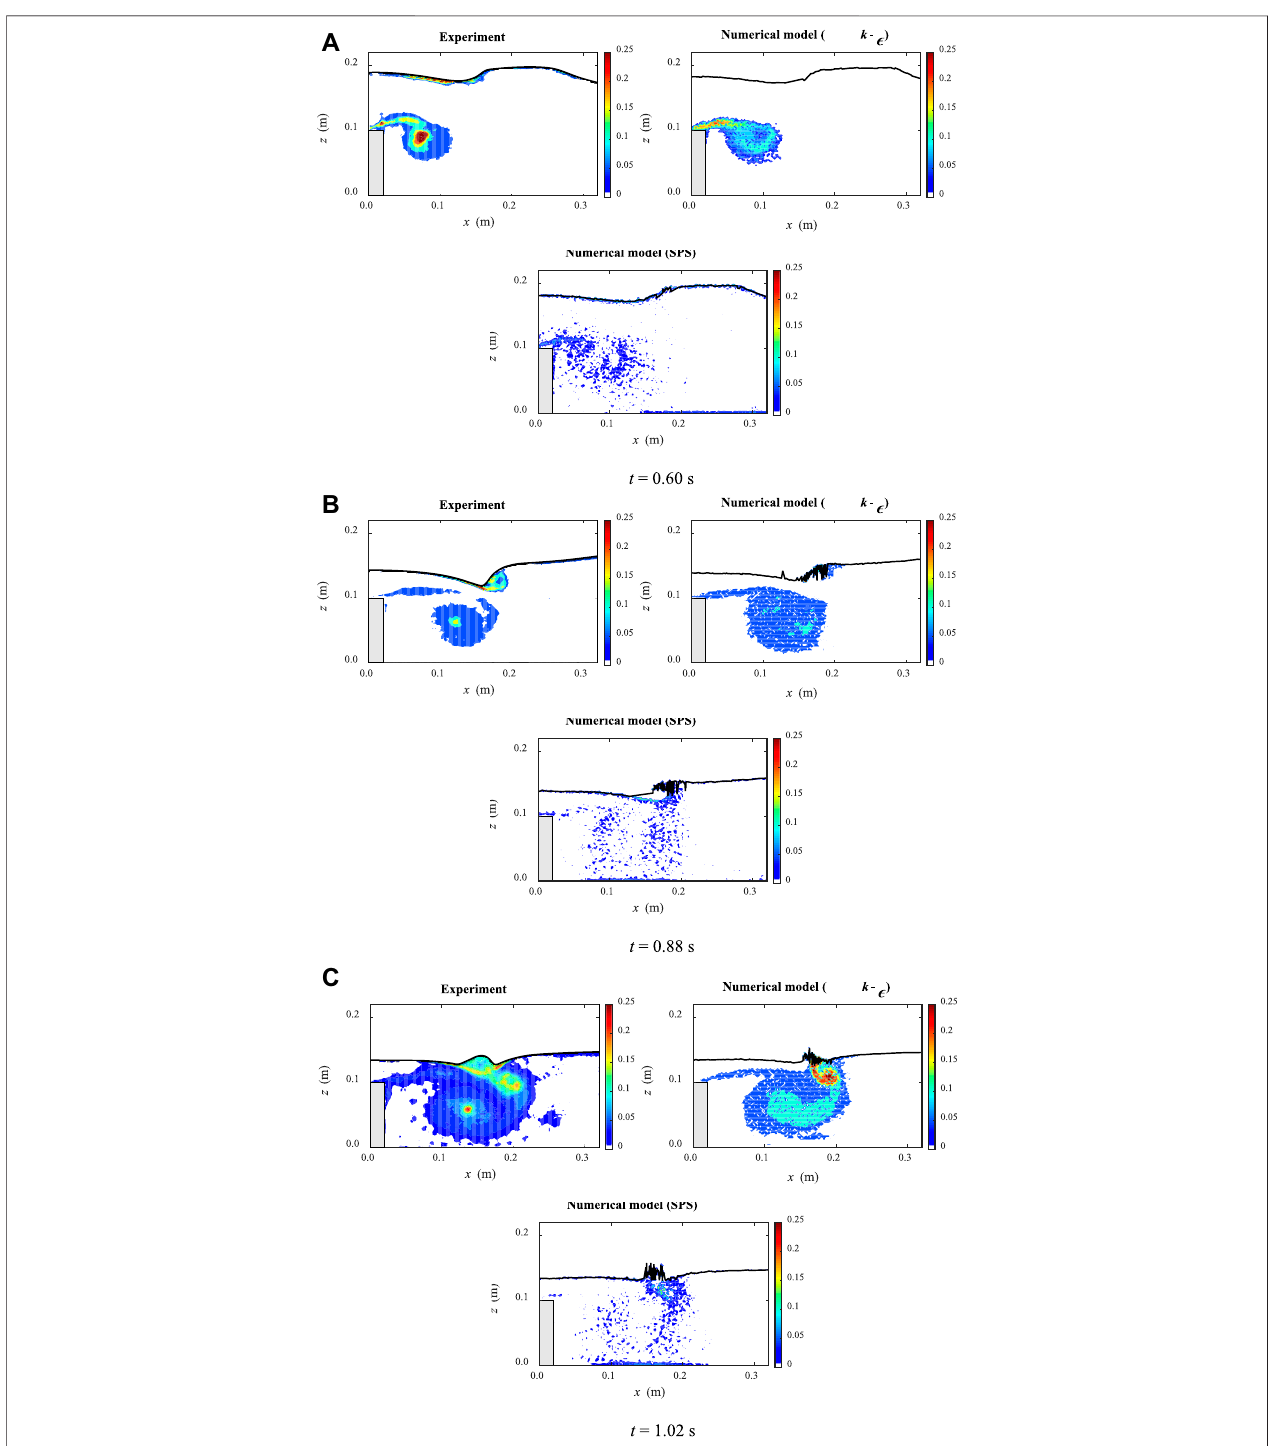
FIGURE6| Comparisonsbetweenexperimental dataandnumericalresultsforthecontoursofturbulentintensity(m/s) atthreetimes t (cid:2) (A) 0.60 s; (B) 0.88 s;and (C) 1.02 s